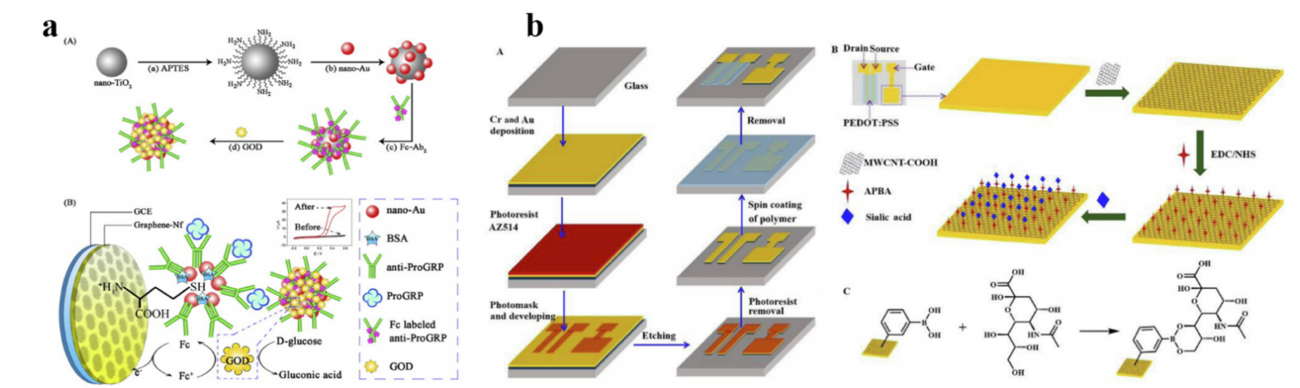
Figure 6. Schematic illustration of electrochemical biosensors fabricated with carbon nanomaterials for detection of lung cancer: ( a ) biosensor fabricated with ferrocene labeled secondary antibodies (Fc- Ab2) and glucose oxidase (GOD) multi-labeled nano-Au/TiO 2 nanospheres for detection of ProGRP, a biomarker of small cell lung cancer [52]; ( b ) biosensor fabricated with organic electrochemical transistor (OECT) for detecting lung cancer related sialic acid [97]. ( a ) and ( b ) Reproduced